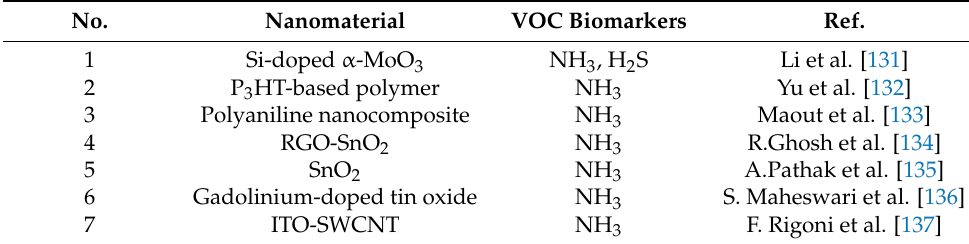
Figure 9. ( a ) NH 3 sensor. ( b ) Senor test bench schematic. ( c ) Resistance vs NH 3 concentration for ( d ) sensor 1—polyaniline/chitosan nanocomposite, ( e ) sensor 4—polyaniline/TiO 2 nanocomposite, ( f ) sensor 5—polyaniline/CNT nanocomposite Reprinted with permission from [133] Copyright 2018 Elsevier. Table 6. Various nanomaterials towards NH 3 biomarkers and their research group. No. Nanomaterial VOC Biomarkers